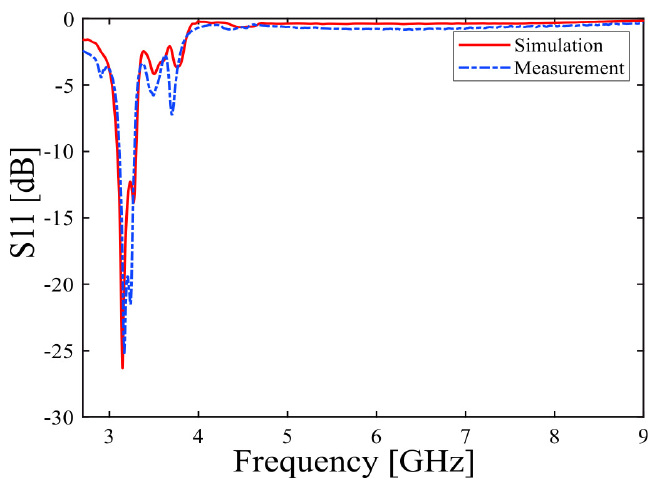
Figure 11. Simulated and measured S11 of the proposed